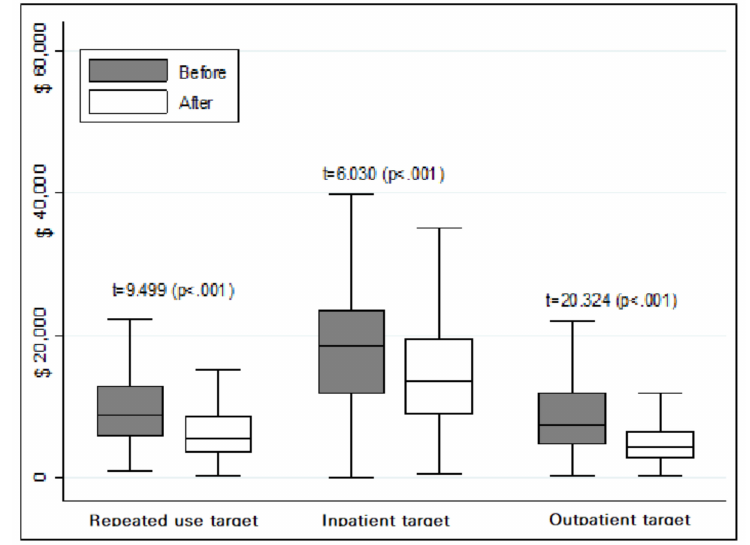
Figure 1. Changes in health care cost in the targeted group.